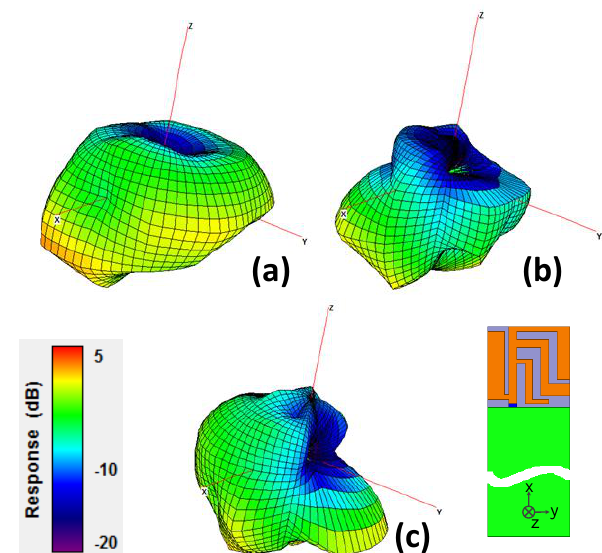
Figure 16. Three-dimensional normalized radiation pattern of the planar USB dongle antenna at ( a ) 2.45 GHz, ( b ) 3.51 GHz, and ( c ) 5.44 GHz.